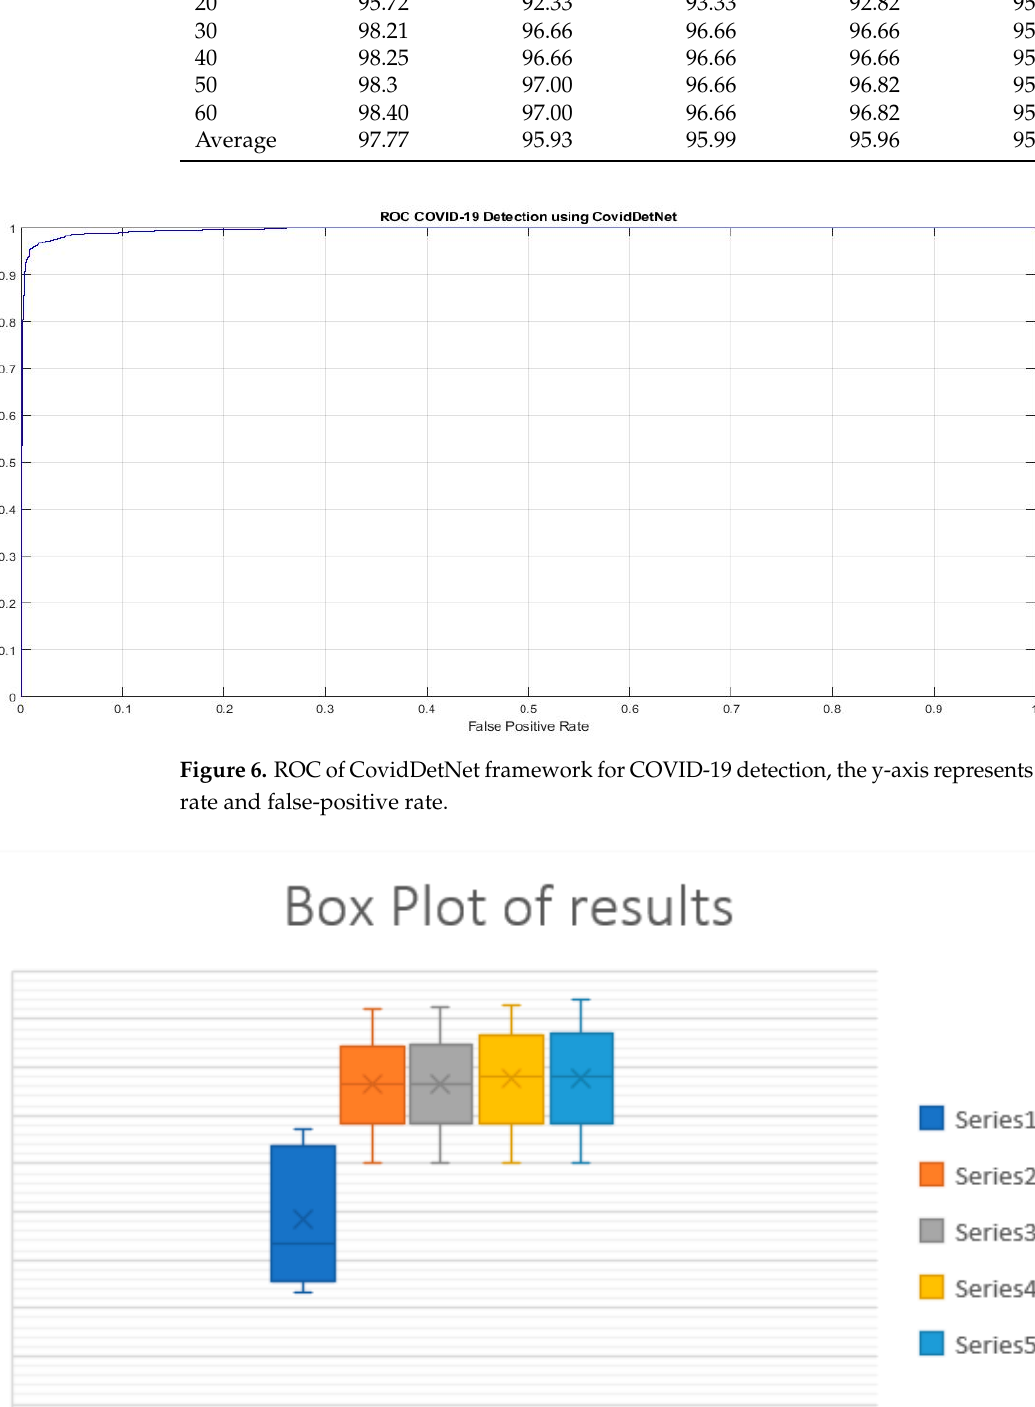
Table 5. Accuracies (in %) on different epochs.